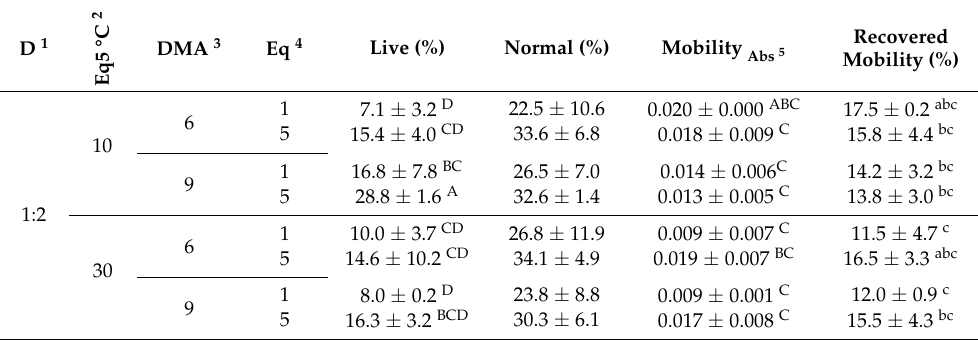
Table 2. Quality parameters of the common pheasant sperm that was cryopreserved according to 16 freezing protocols that differed according to the two levels employed in each step (dilution, equilibration at 5 ◦ C, DMA concentration, equilibration time with DMA) of the freezing process (means ± SD). 2 C ° D 1 DMA 3 Eq 4 Normal Eq 5